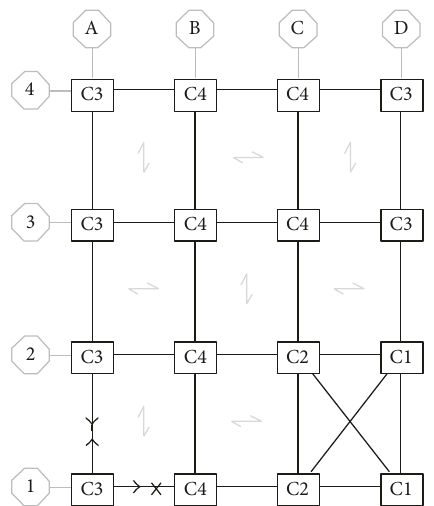
Figure 22: Typical plan view of steel columns.